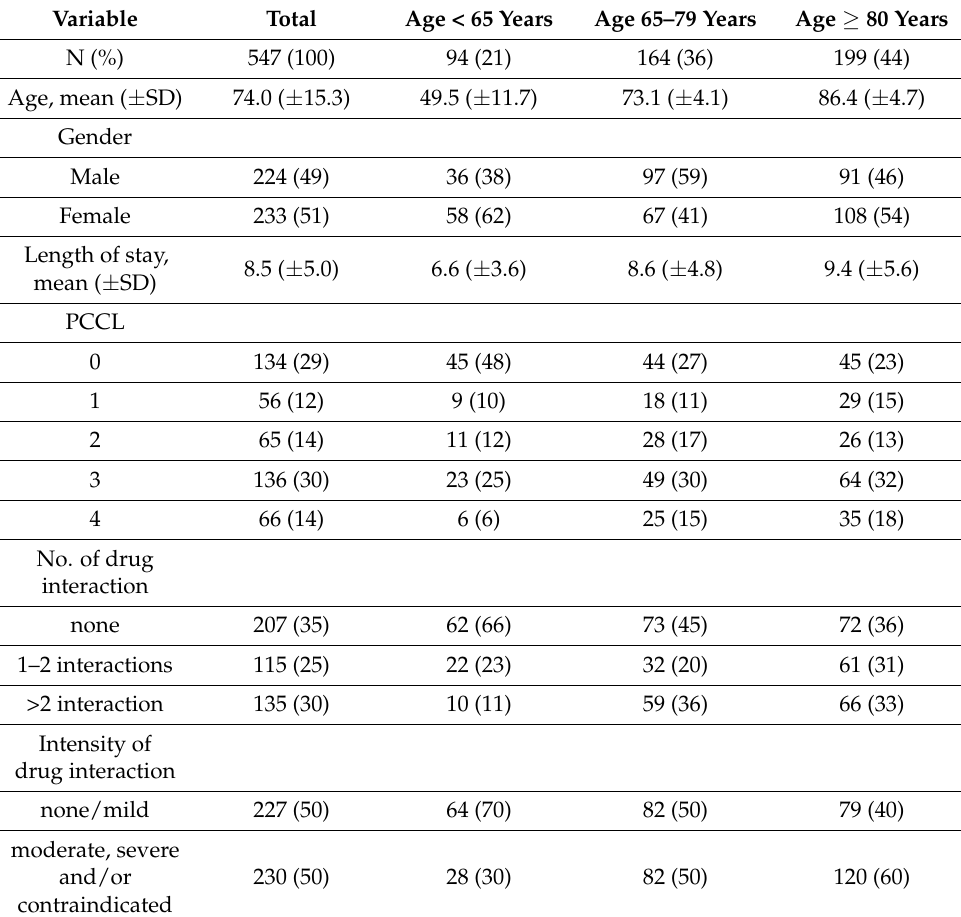
Table 1. Patient characteristics for the total group and the different age